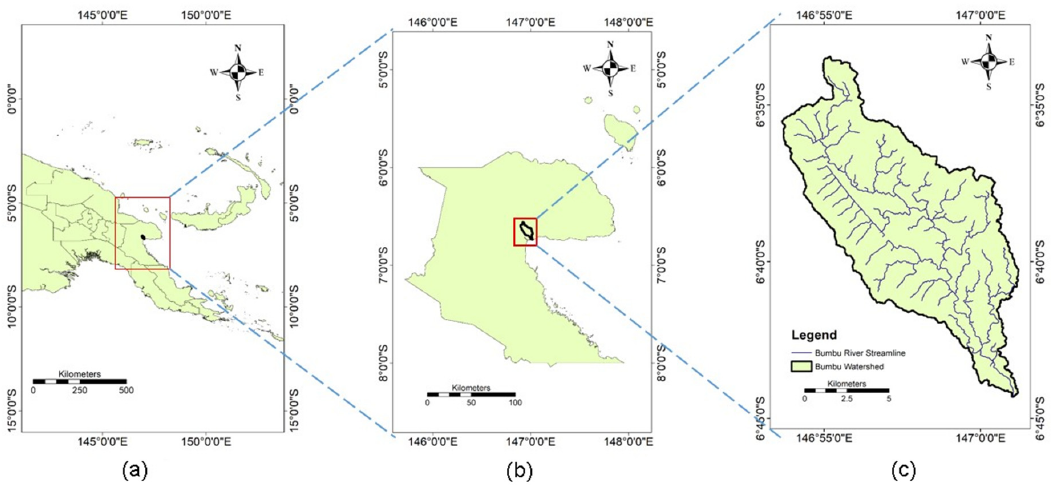
Figure 1. Depiction of the study area on different scales: ( a ) Papua New Guinea (PNG), ( b ) Morobe Province, ( c ) Bumbu basin.